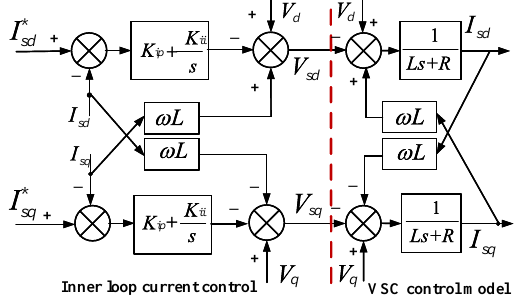
Figure 3. Structure of inner current loop.